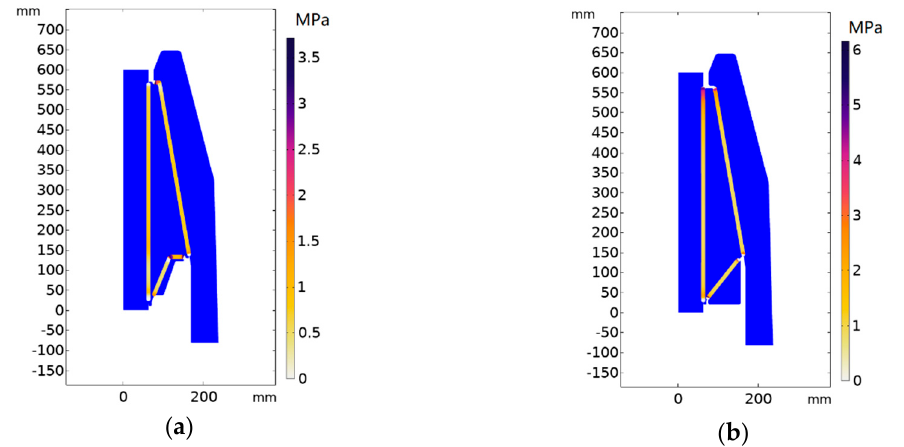
Figure 13. The contact pressure distributions of the original prototype and its optimized design are presented in ( a ) and ( b ), respectively. The cable insulation radius is 62 mm and the total spring force is 30 kN. Friction and adhesion are ignored.